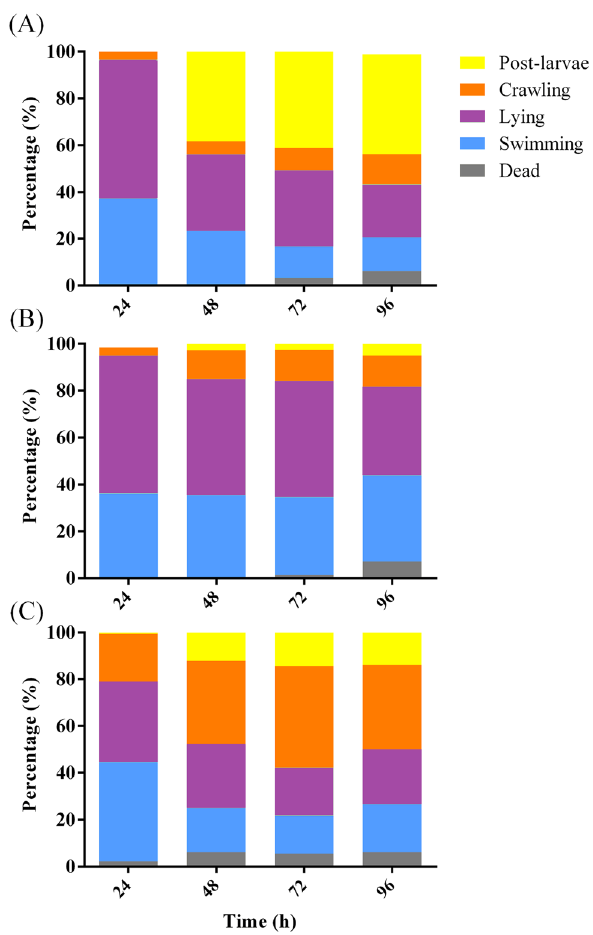
Figure 5. Behavior change of mussel larvae exposed to deep-sea Virgibacillus sp. 1 BF ( A ), AFSW ( B ), and CW of Virgibacillus sp. 1 BF. Means (n = 9).